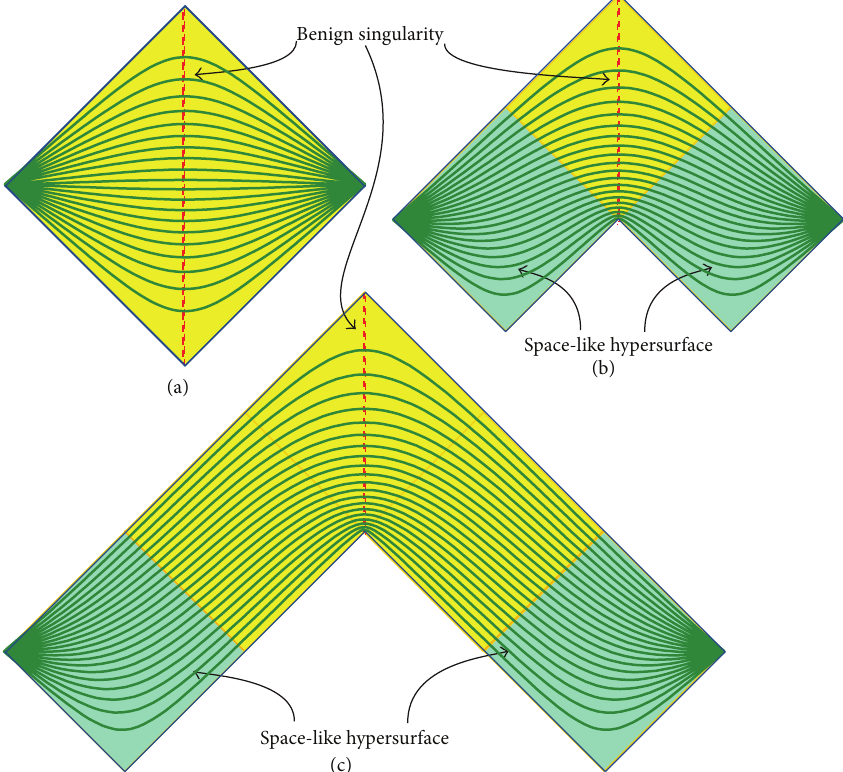
Figure 3: Reissner-Nordstr¨om black hole solutions, extended beyond the singularities and restricted to globally hyperbolic regions. (a) Naked solutions ( 𝑞 2 > 𝑚 2 ). (b) Extremal solution ( 𝑞 2 = 𝑚 2 ). (c) Solutions with 𝑞 2 < 𝑚 2 .